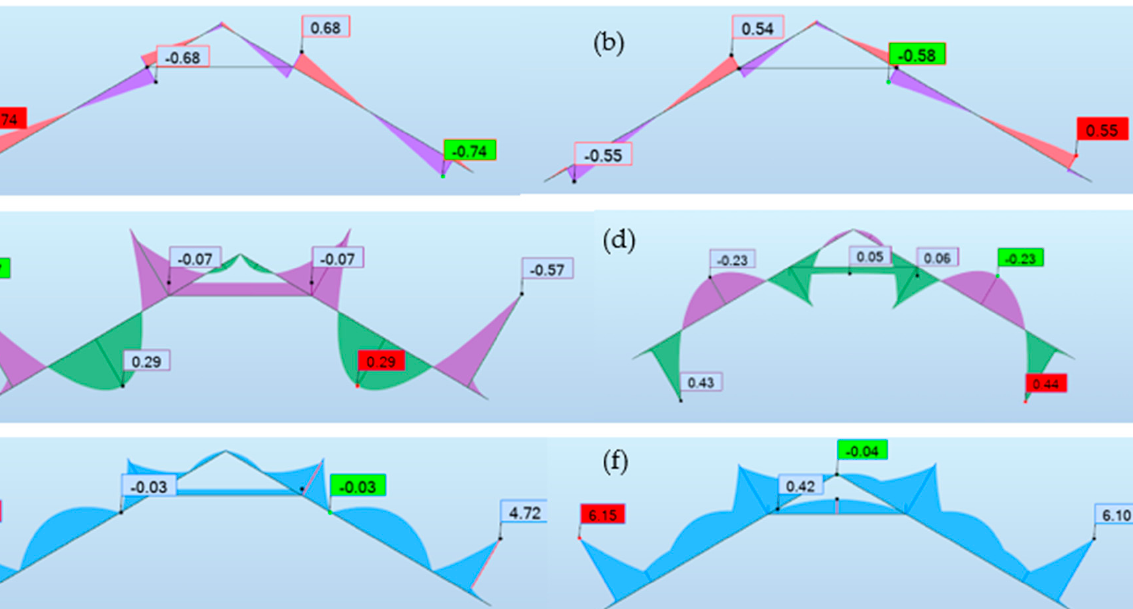
Figure 12. Deformation of the roof structure: ( a ) the entire roof structure, andthe most loaded pair of rafters (( b )—W1, ( c )—W2, ( d )—W3).